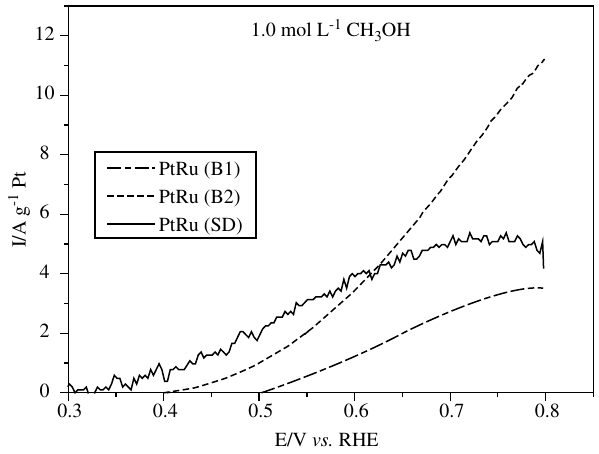
Figure 5. Oxidation of methanol in a 1.0 mol L -1 methanol solution at scan rate of 10 mVs -1